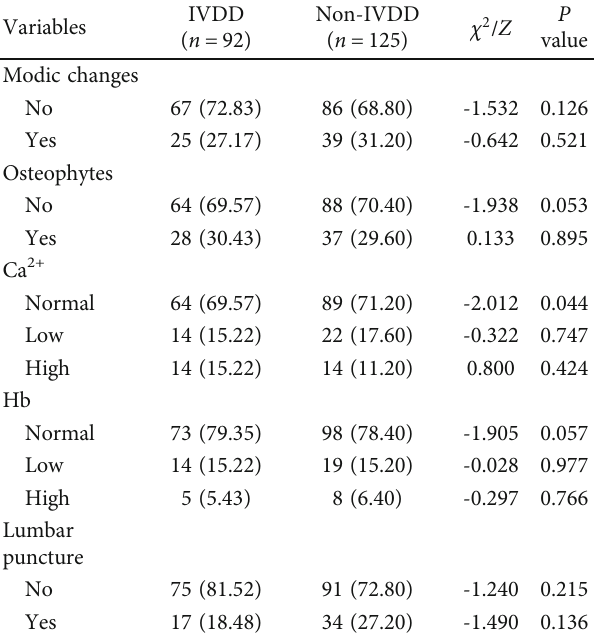
Table 2: Univariate logistic regression analysis of the training